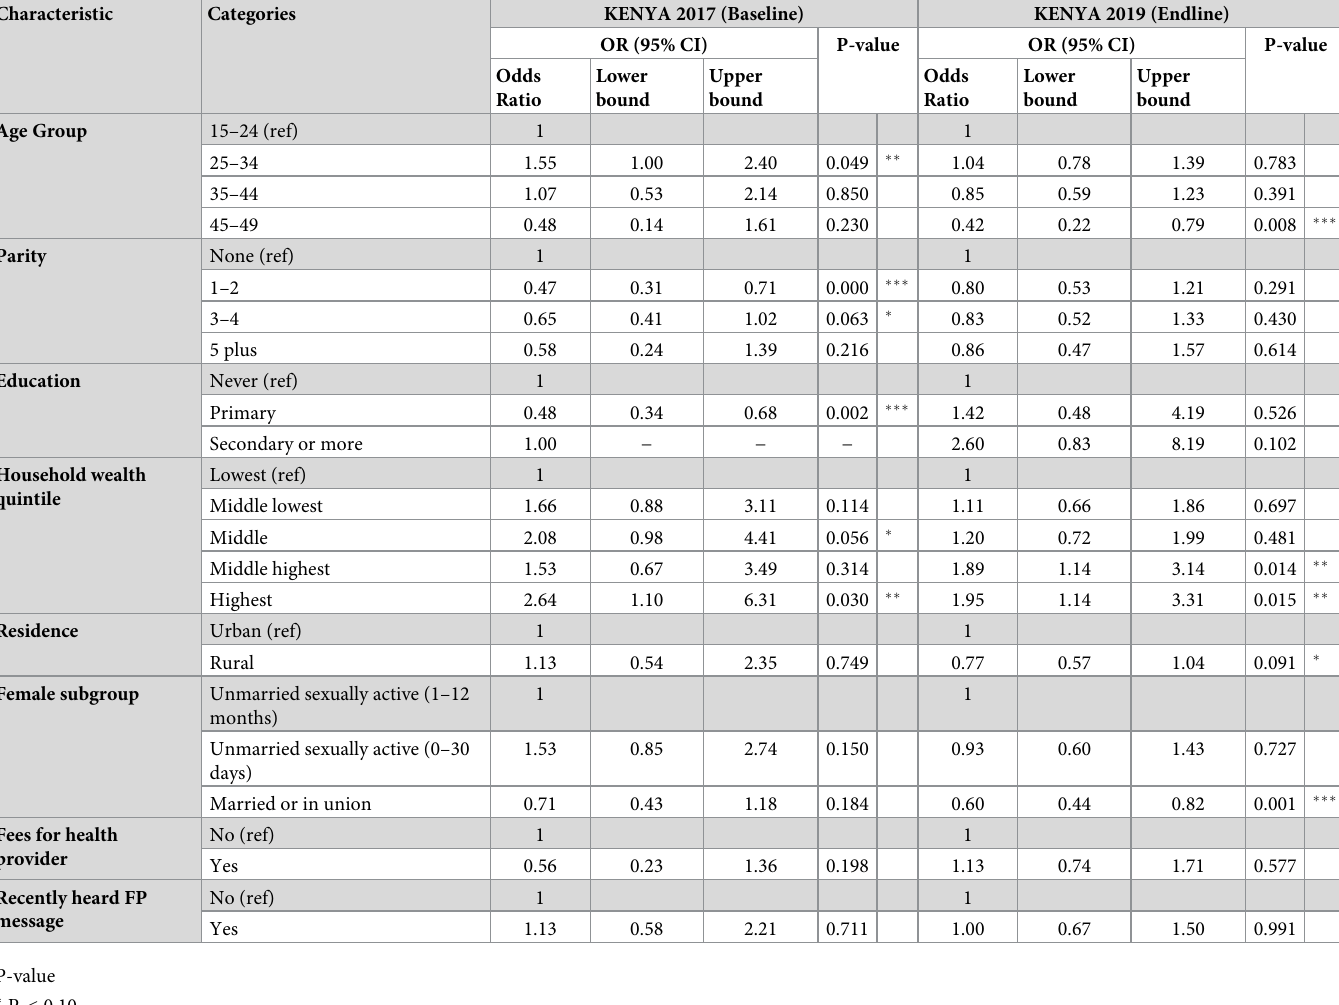
Table 7. Logistic regression model for recent emergency contraceptive use (in last 12 months) by survey round, PMA/Kenya (2017, 2019). Characteristic Categories